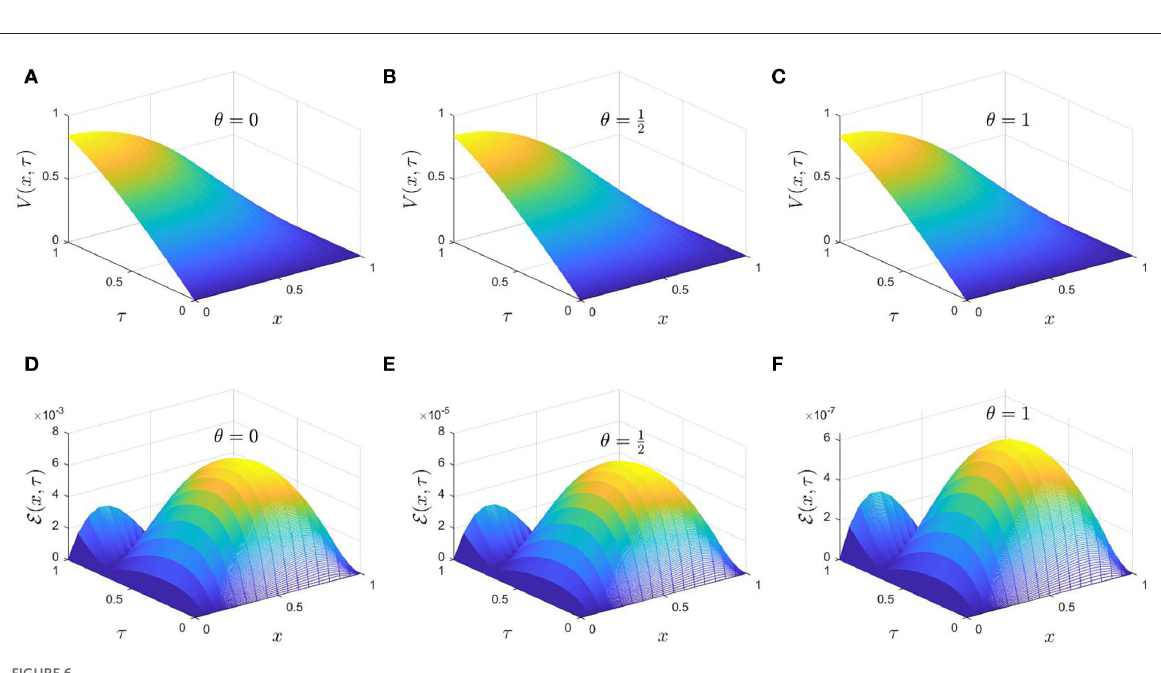
, 1 and their corresponding absolute errors. 0, 1 2 =